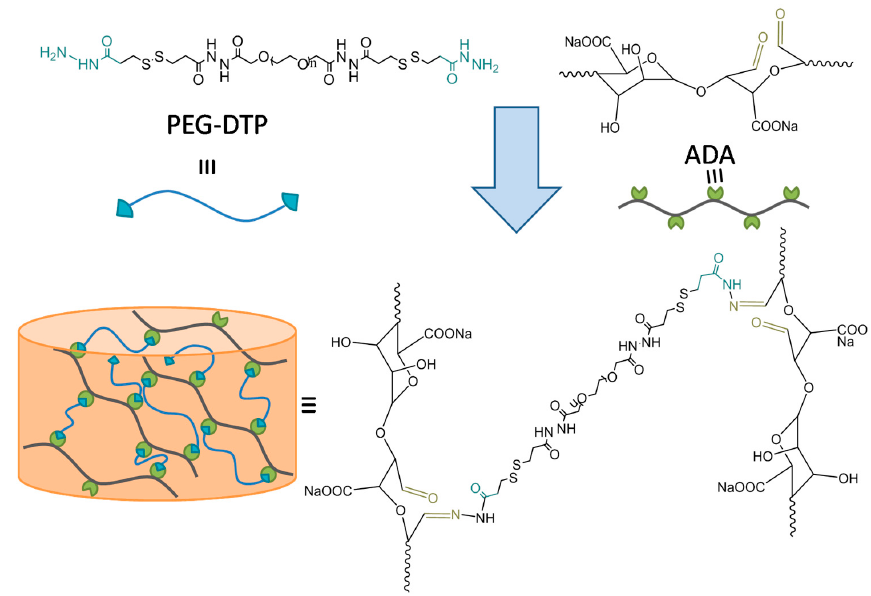
Figure 1. Schematic diagram of the preparation of the PEG-DTP/ADA hydrogel.